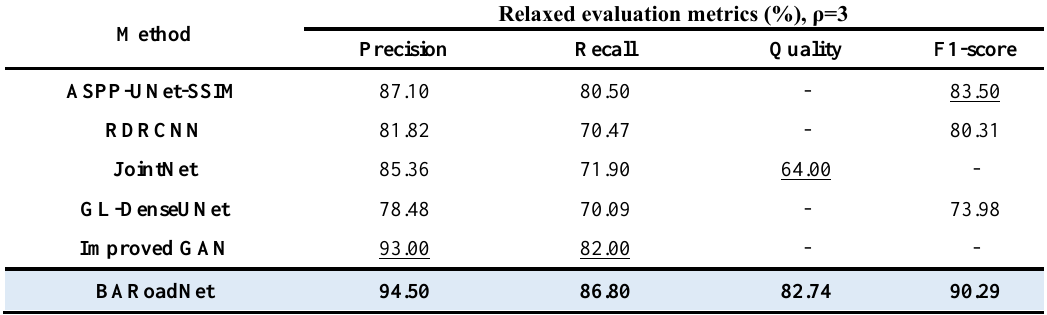
Table 1 Quantitative evaluation on the Massachusetts Road Dataset Table 1 indicates that the precision, recall, quality and